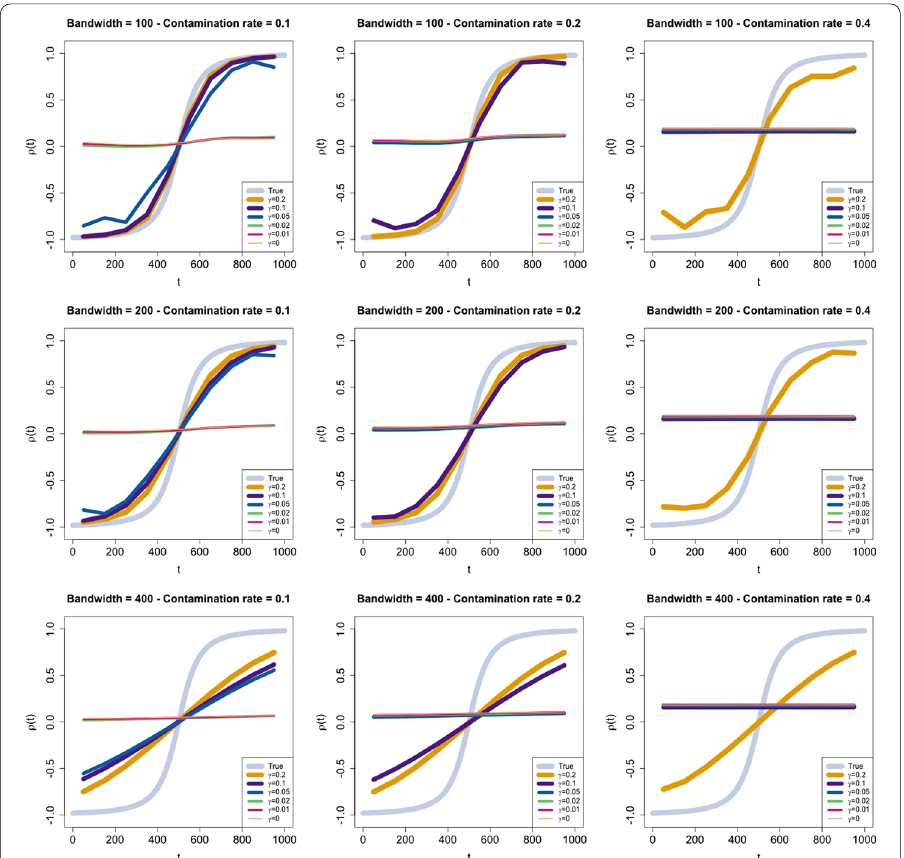
Fig. 1 Dynamics of the estimated correlation coefficient. The parameters are estimated at 10 points, that is, t ∗ = 50,150,250, ... ,950 . Each row corresponds to a bandwidth, that is, h = 100,200 , and 400, whereas each column corresponds to a contamination rate, that is, ǫ = 0.1,0.2 , and